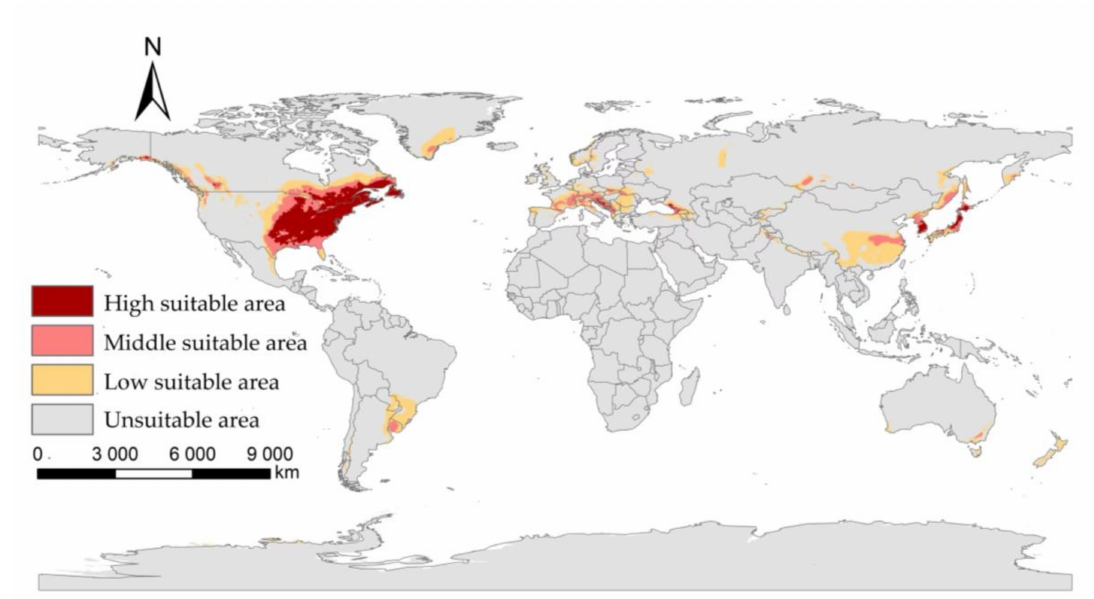
Figure 3. The suitable areas of I. scapularis under near current climatic